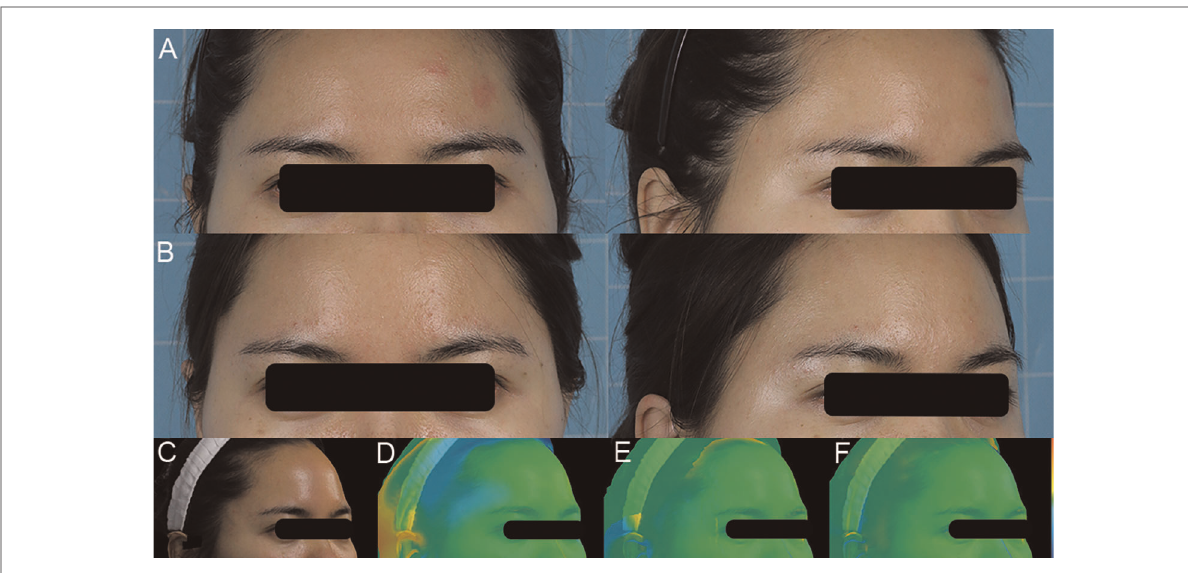
FIGURE 8 A 31-year-old female patient presented with temporal hollowness. A total of 8 ml of Coleman ’ s fat was injected into both temples. Temporal hollowness was improved at the 12 months follow-up. ( A ) Preoperative front and right oblique photos. ( B ) Preoperative front and right oblique photos at 12 months. ( C ) Preoperative right oblique photo. ( D – F ) 3D reconstruction of right oblique images at 1, 6, and 12